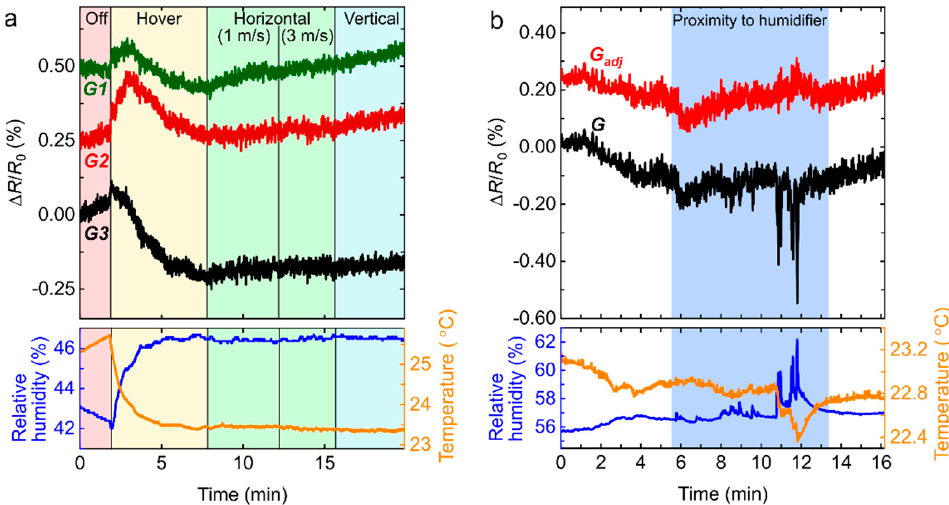
Figure 6. The sensing platform mounted on a flying drone measures and relays in real-time the changes in resistance of graphene sensors while also monitoring the relative humidity and temperature with a commercial sensor (bottom panel). ( a ) The changes in the sensing response as a function of drone motion is investigated by performing measurements when the drone is powered off and on the ground (red region), hovering (yellow region), moving horizontally at speeds of 1 m/s and 3 m/s (green regions), or moving vertically (blue region). ( b ) As the flying drone is approaching a humidifier, the signal G relayed by the graphene sensors (only one is shown here) features large irregular oscillations. Equation (1) and parameters listed in Table 1 allow us to calculate G adj , a signal independent of environmental variations such as humidity and temperature changes.